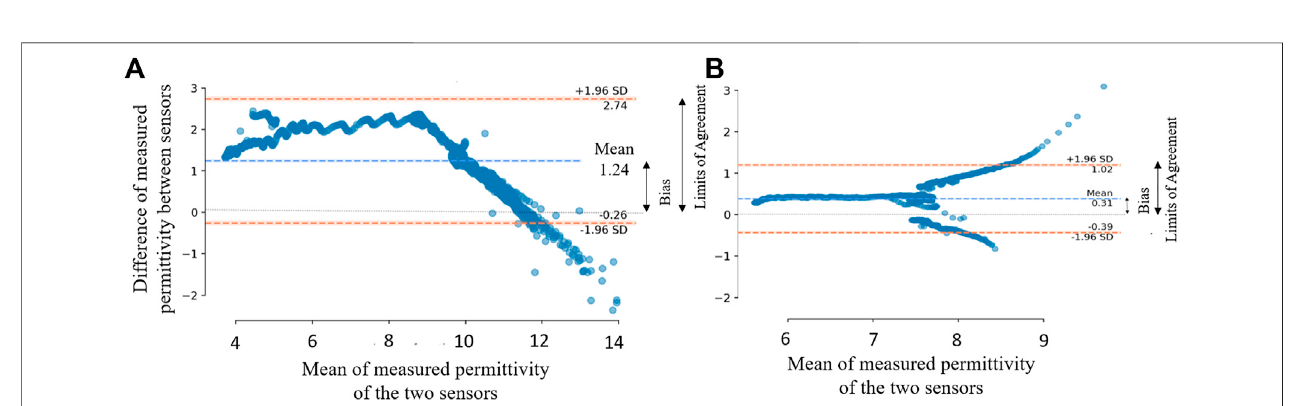
FIGURE 4 | Result of a Bland- Altman analysis (Bland and Altman, 1999) for two x two sensors at a depth of 15 cm (A) and 45 cm (B) . Panel shows the mean difference betweentwosensors at onedepth (blue dotted line), expressingthe biasto thecorrespondingzero difference. The precision range betweenthe LOA (orange dotted line) is much smaller for the deeper sensors than the shallower sensors. Also, the curve for the deeper sensors indicates a nearly consistent behavior (constant variability until x (cid:1) 7.8) followed by a constant coef fi cient of variation that proves an internal consistency. The lower sensors indicate a more signi fi cant bias and do not show constant variation coef fi cients; therefore, they cannot be classi fi ed as consistent.